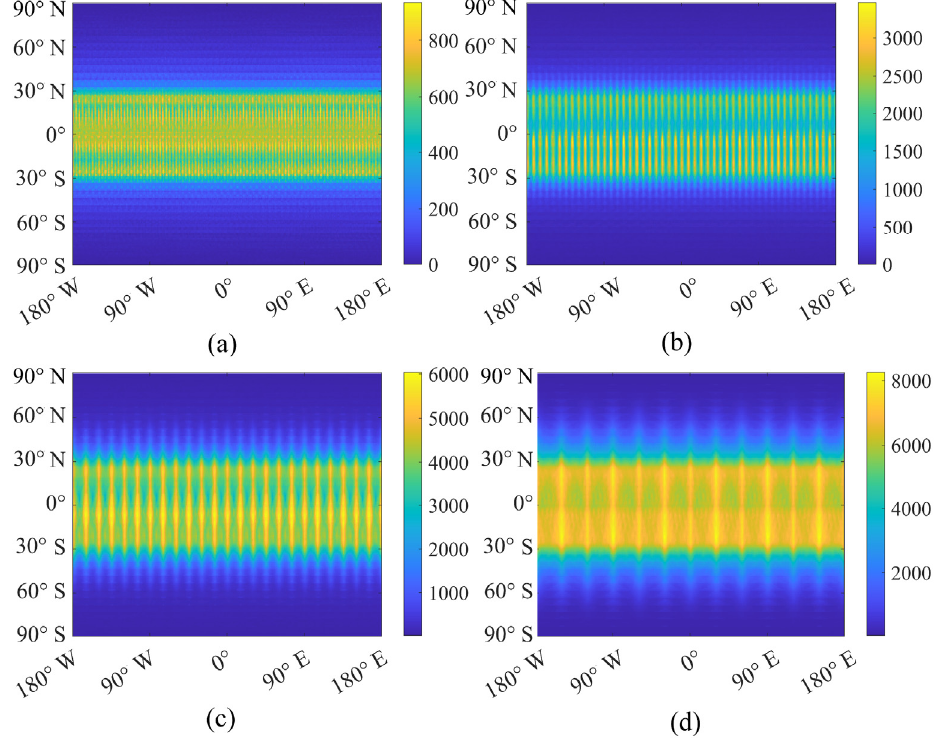
Figure 8. Difference maps between global ACNI maps at time sampling intervals of ( a ) 30 min, ( b ) 1 h, ( c ) 2 h, ( d ) 4 h, and 10 min.